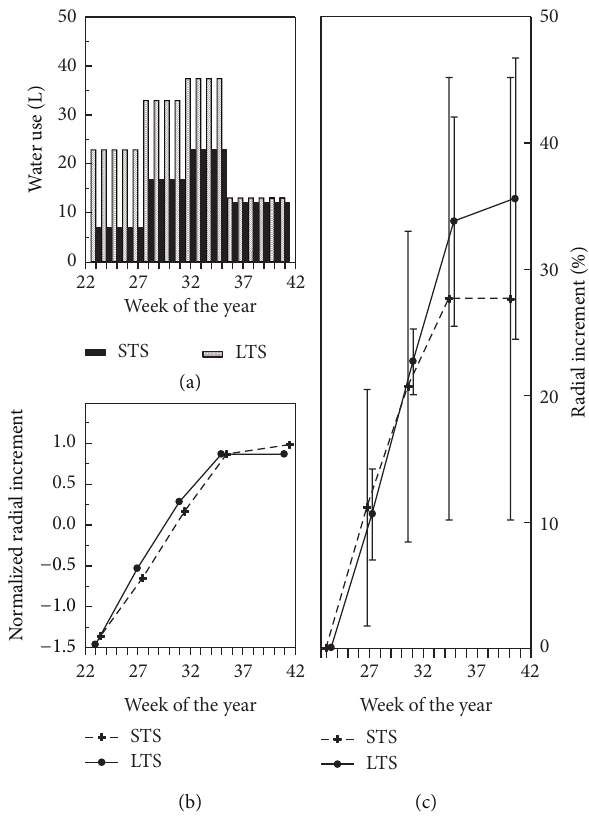
Figure 7: (a) Mean weekly water use and (b) mean and standard deviation of the primary branches relative radial increments mea- sured with caliper and (c) mean primary branch radial increments normalized, measured with caliper.